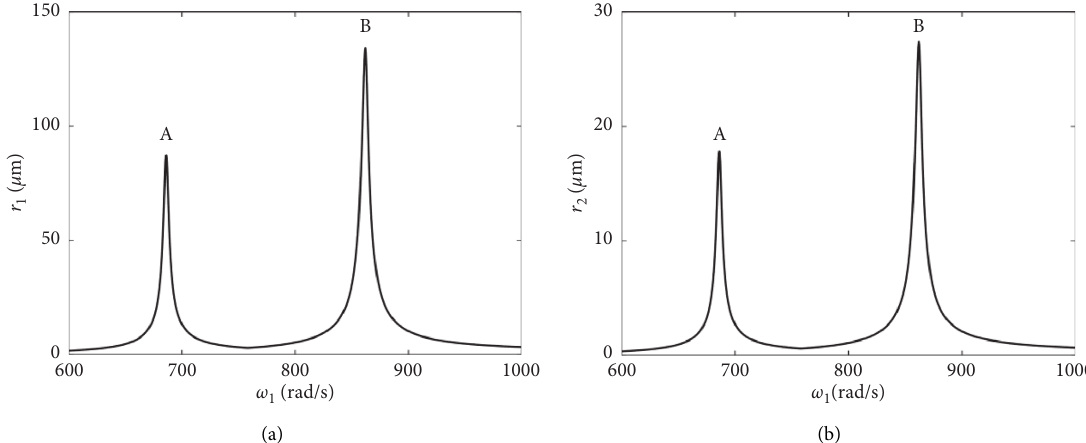
− k n s parameters plane.